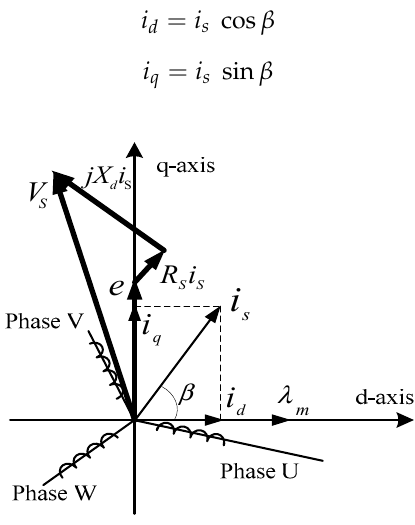
Figure 2. Voltage and current vectors.